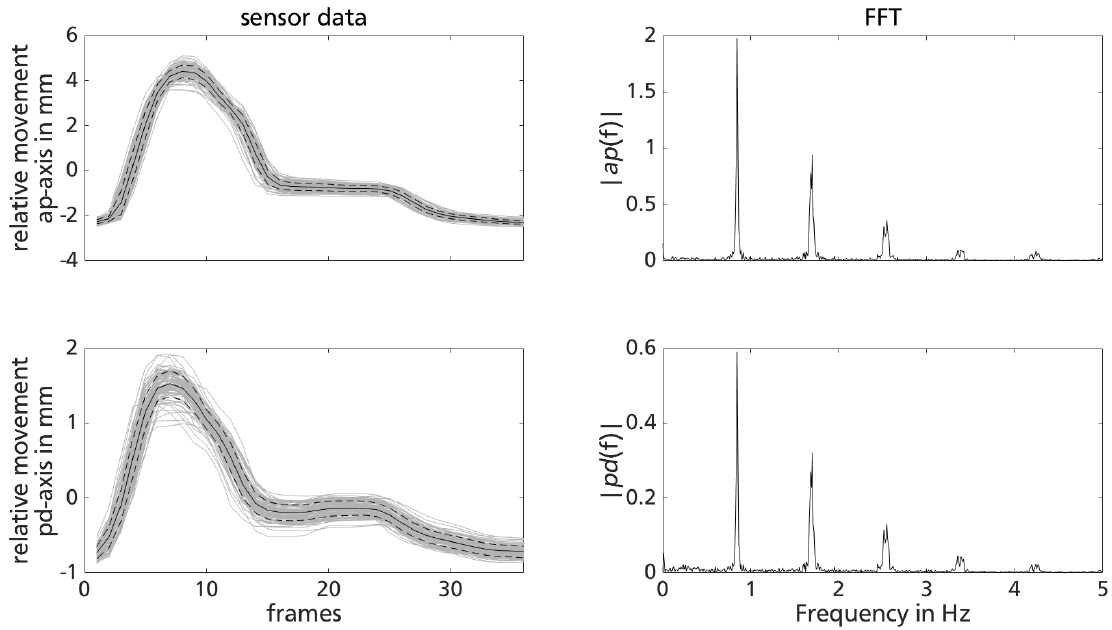
Figure 11. Representative plot for sensor data evaluation: mean ± standard deviation (black lines) of identified repetitive pattern in sensor data for both directions ( left ) as well as results of FFT ( right ) for trial session of partic. 1 with v tm m .